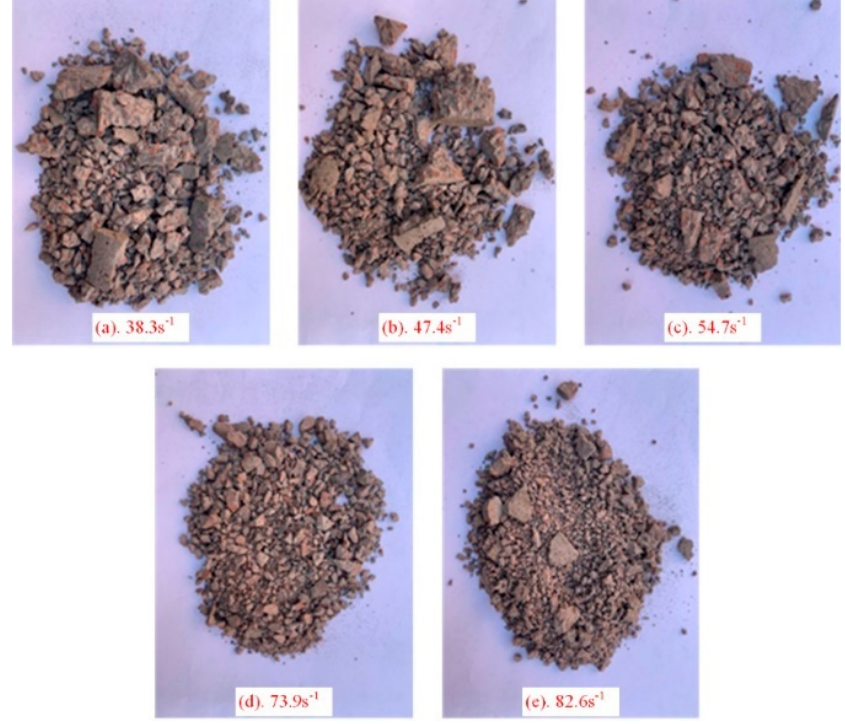
Figure 12. Failure and fractal nature of S 5–1.0-I cemented rock samples under different strain rates.